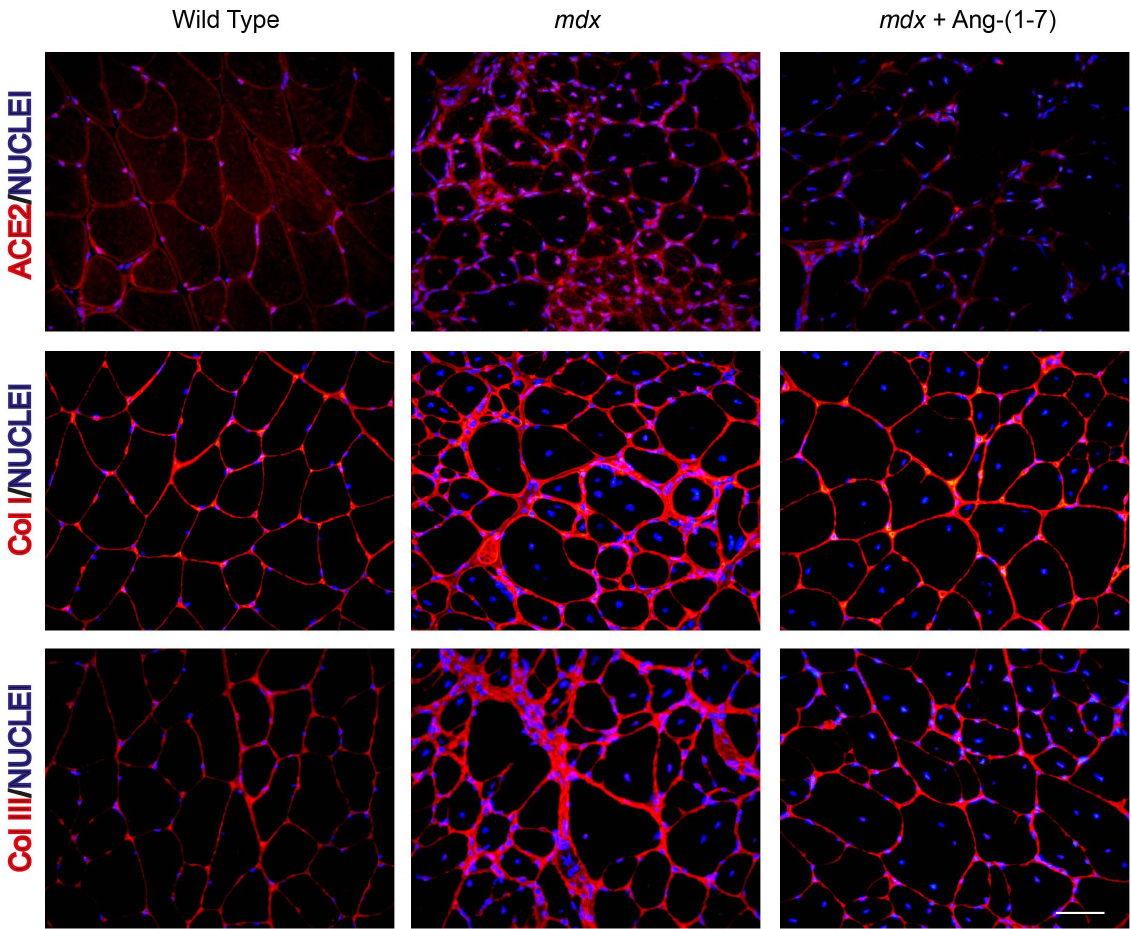
Figure 7. Angiotensin-(1-7) infusion reduces fibrosis and decreases ACE2 expression in mdx muscle. mdx mice were treated with Ang- (1-7) by systemic infusion for 8 weeks. ACE2, Col I, and Col III immunostaining in sections of GAST muscle from wild type (WT), mdx, and mdx mice treated with Ang-(1-7) is shown. Nuclei were stained with Hoechst. Bar 50 um.